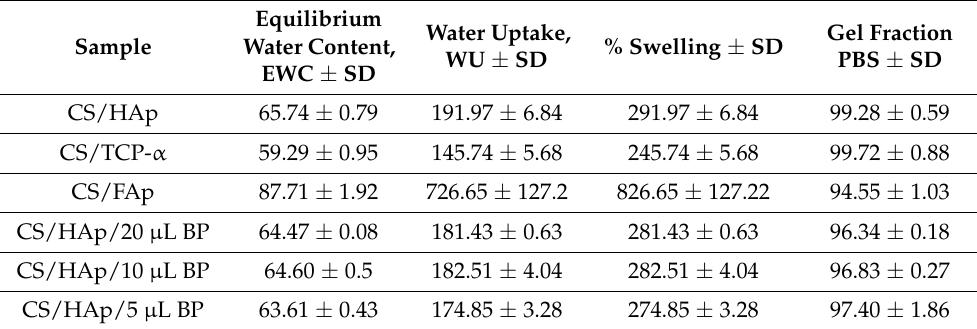
Table 2. Swelling studies of chitosan scaffolds with different ceramics (HAp, TCP- α and FAp) and benzophenone contents (20, 10 and 5 µ L), comprising the EWC, WU, percentage of swelling and gel fraction in